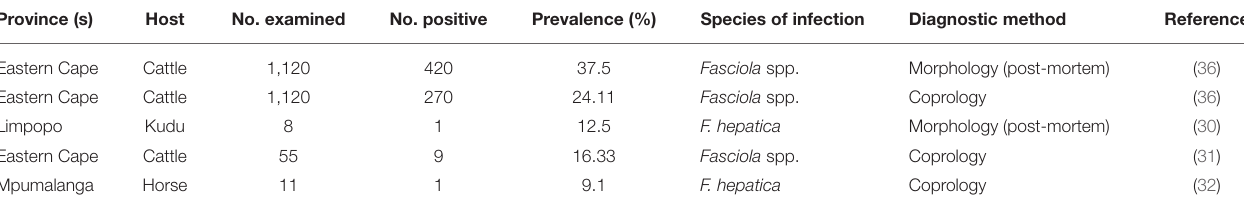
TABLE 3 | Information from reviewed publications on the prevalence of Fasciola spp. in humans, wildlife and livestock from South Africa. Province (s)